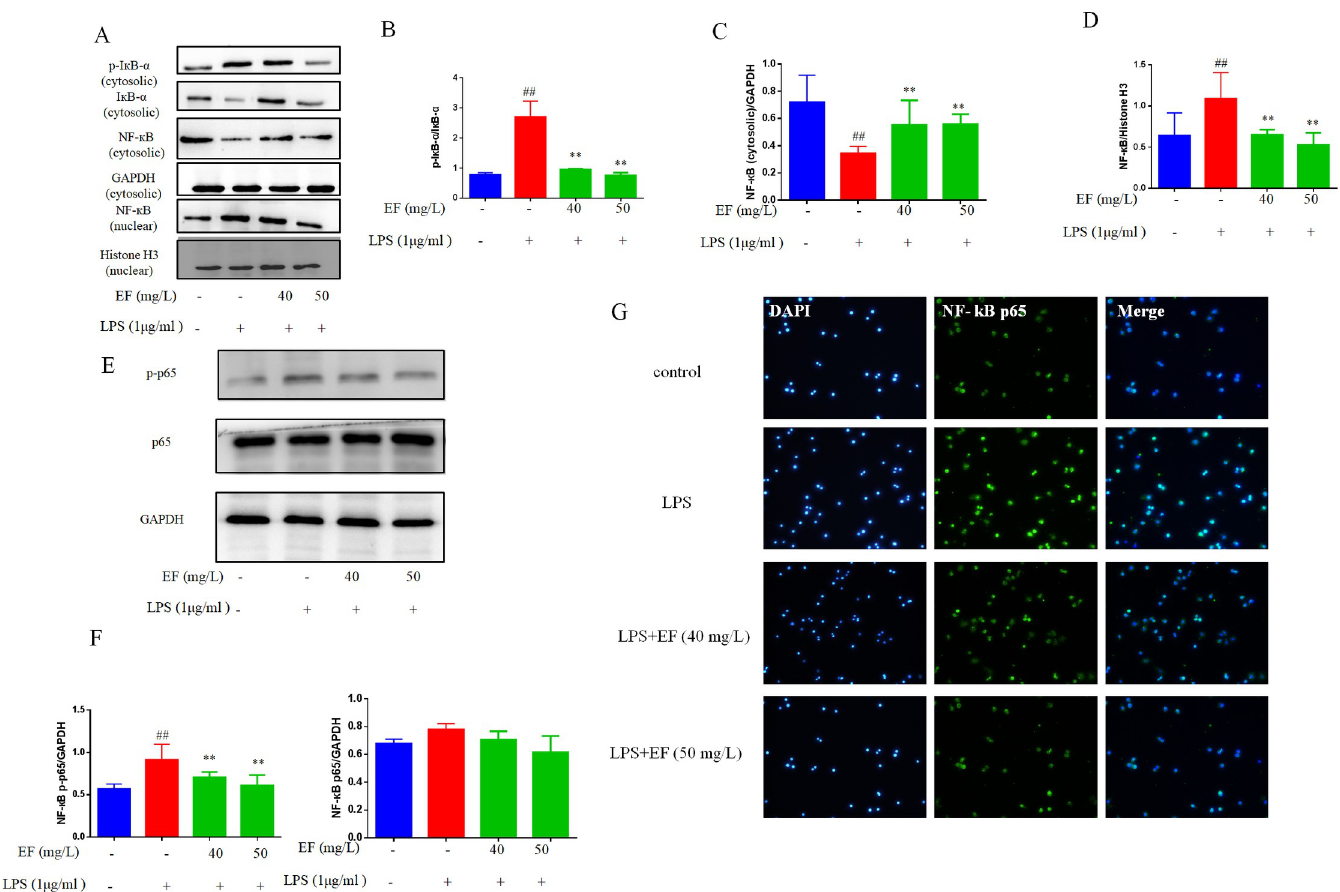
Fig 4. EF down-regulated LPS-stimulated NF- к B activation in RAW 264.7 macrophages cells. A/B/C/D/E/F: The protein levels of p-I к B- α , I к B- α , NF- к B p65 in cytosolic and NF- к B p65 in nuclear, and p- NF- к B p65 were determined by Western blotting analysis using specific antibodies. G: NF- к B p65 was determined using immunofluorescence analysis (50 μ m). All data are shown as mean ± SEM (n = 6, per group) ##P < 0.01 vs control; �� P < 0.01 vs LPS.